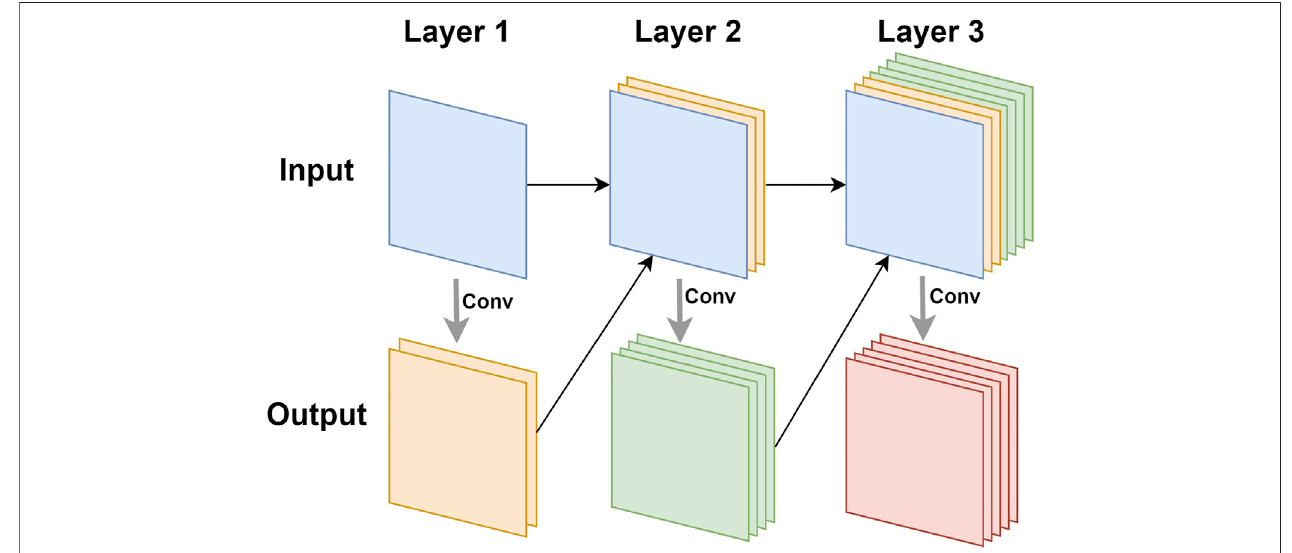
FIGURE 4 | The illustration of feature reuse of dense